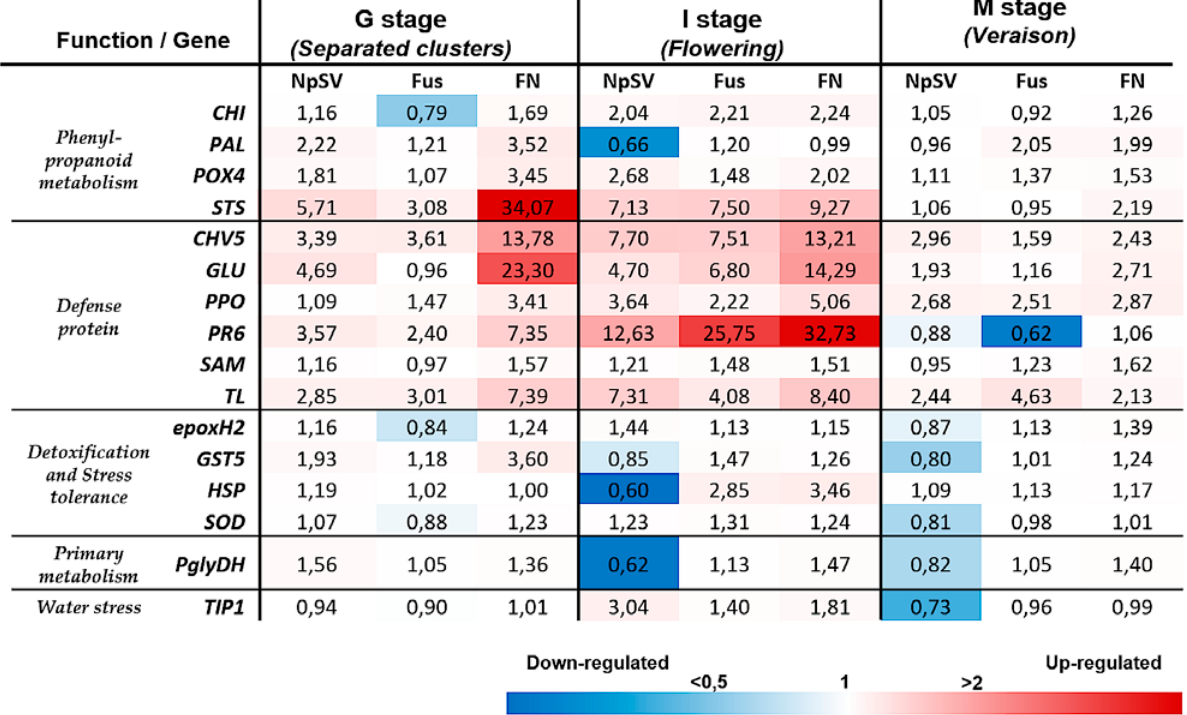
Figure 7. Expression levels of selected genes (determined with quantitative reverse-transcription polymerase chain reactions). The values (each the mean of three technical replicates) represent expression levels (ΔΔCt) of treatments relative to the controls (C2). The expression of each gene was considered up-regulated when the value was > 2-fold compared to the controls, or down-regulated when the value was < 0.5-fold compared to the